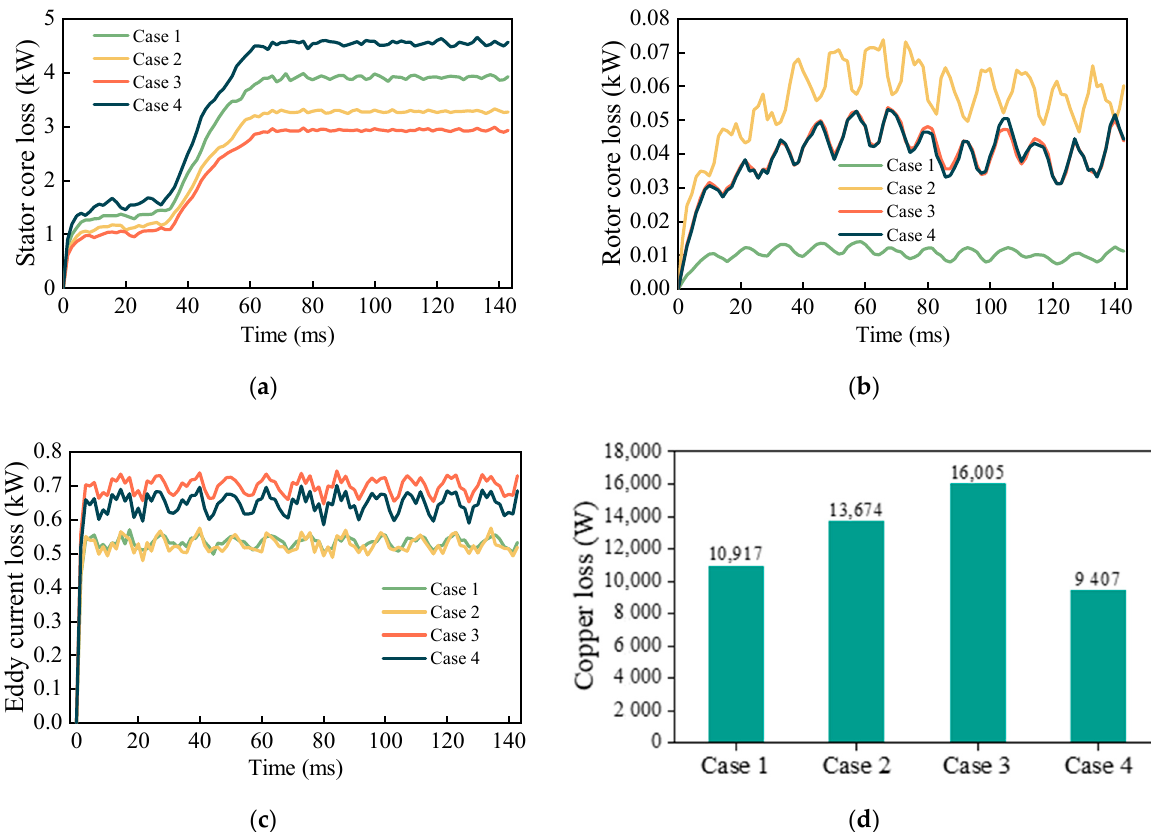
Figure 15. Loss of four schemes under rated load: ( a ) stator core loss; ( b ) rotor core loss; ( c ) eddy current loss of the PM; ( d ) copper loss.